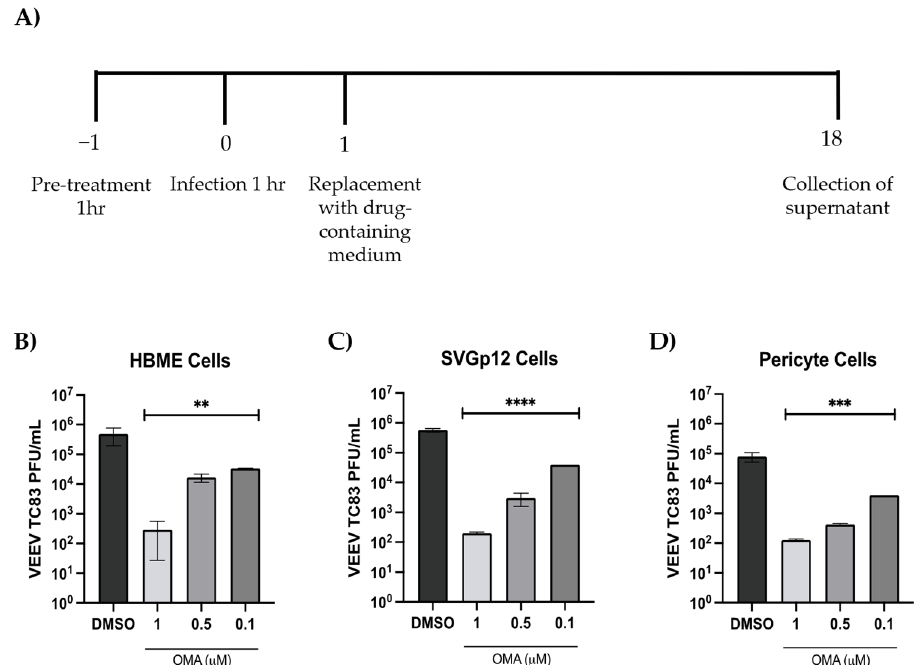
Figure 3. Dose–dependent inhibition of VEEV-TC83 in endothelial cells, astrocytes and pericytes following OMA treatment. ( A ) Schematic representing the dosing and infection strategy. Endothelial cells ( B ), astrocytes ( C ) and pericytes ( D ) were plated in 96-well plates and infected with VEEV-TC83 (MOI:0.1). These cells were pretreated with culture medium containing increasing concentrations of OMA for 1 h prior to infection. After infection, the drug-containing media were added back to the cells and cells were maintained at 37 °C for 18 h. Culture supernatants were obtained at 18 h and viral load was quantified by plaque assay. Infectious viral titer is indicated as plaque forming units (PFU)/mL relative to the DMSO control sample. Data represent the average of three independ- ent samples. Statistical analysis was performed using One-way ANOVA with Dunnett’s post-test. ** p < 0.01, *** p < 0.001, **** p < 0.0001.